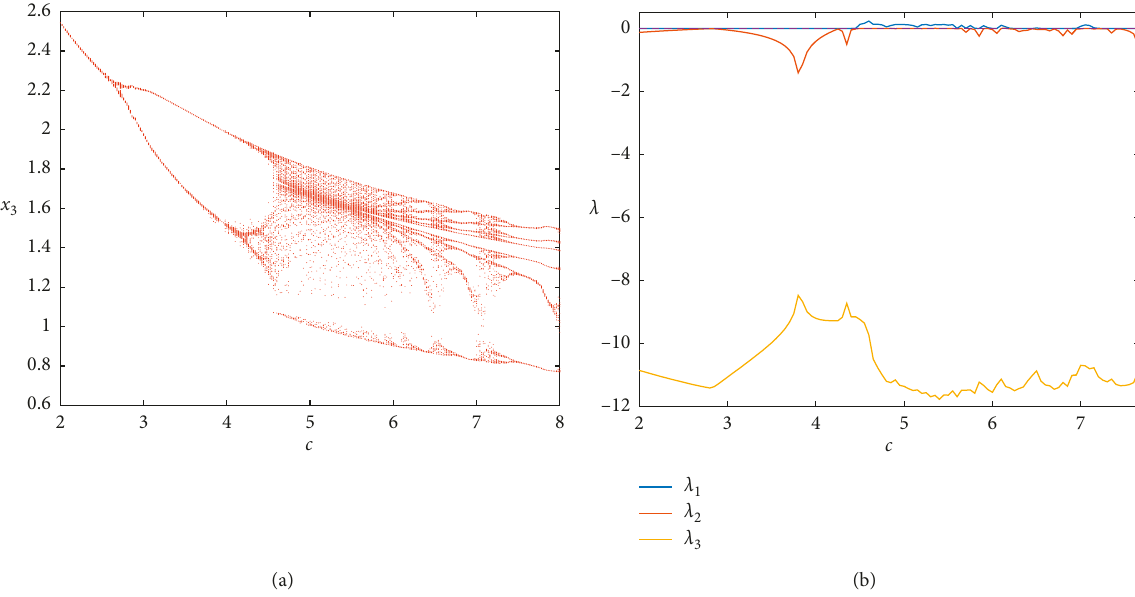
Figure 4: (a) Bifurcation diagram and (b) Lyapunov exponents of system (1) versus parameter c